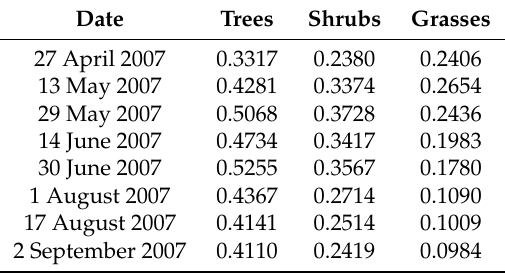
Table 1. Mean actual Landsat-5 Normalized Difference Vegetation Index (NDVI) for each date and vegetation type in Dry Creek Experimental Watershed (DCEW), Idaho, USA. This was used to normalize/standardize the vegetation type and aspect figures. Date Trees